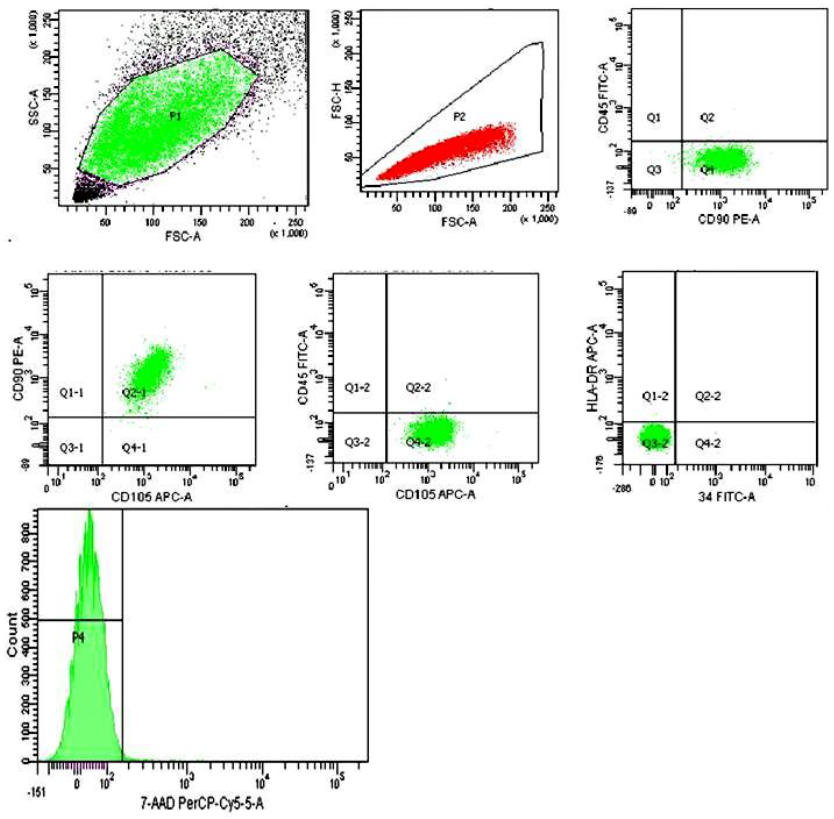
Figure 1. MSCs derived from the placenta immunophenotype: CD90 +/ CD105 + 73 +/ CD45 − / CD34 − / HLA-DR − , 7 − ADD (99.5%). Cells 2020 , 9 , x FOR PEER REVIEW